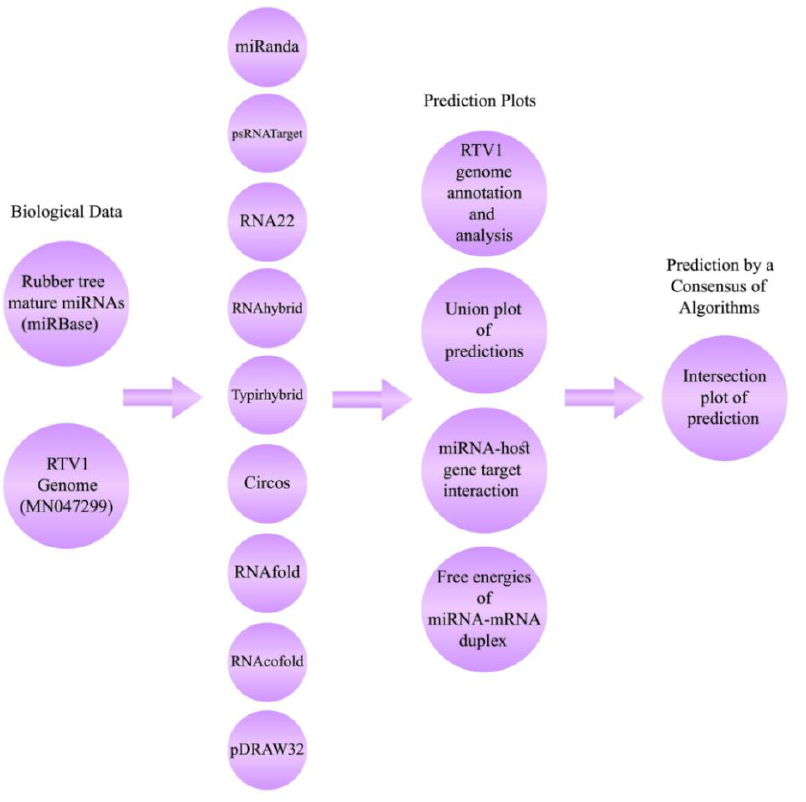
Figure 1. A computational biology scheme and methodology of rubber tree miRNA prediction from the RTV1 genome.